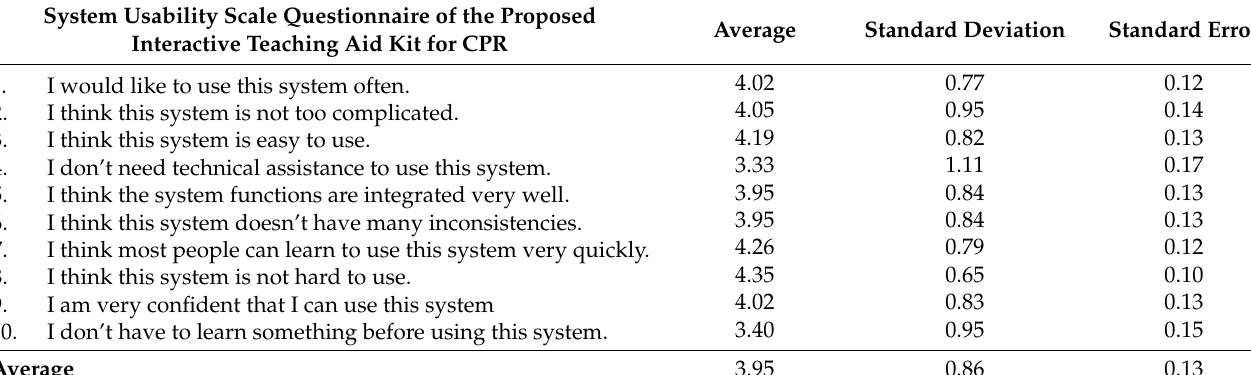
Table 3. The analysis of the questionnaire.